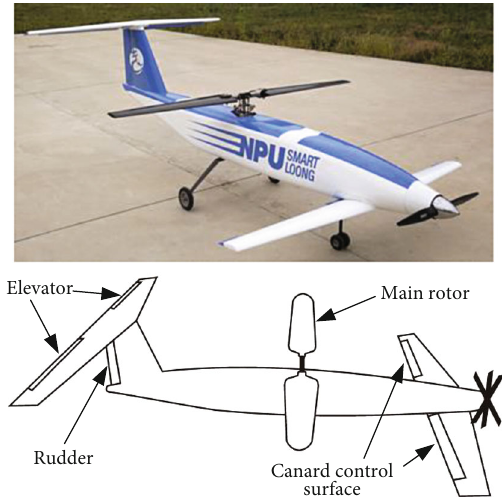
Figure 1: Illustration of the studied hybrid CRW